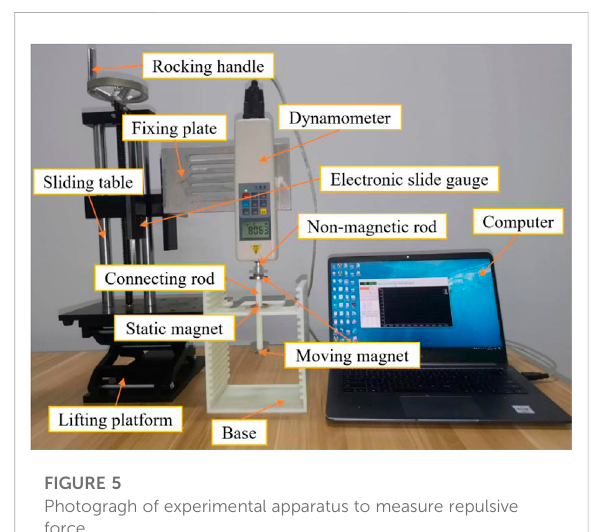
FIGURE 5 Photogragh of experimental apparatus to measure repulsive